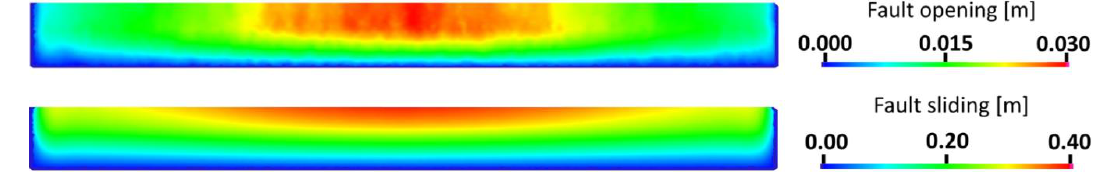
Figure 6. Test case 2: opening and sliding on the fault after 10 years of water extraction.